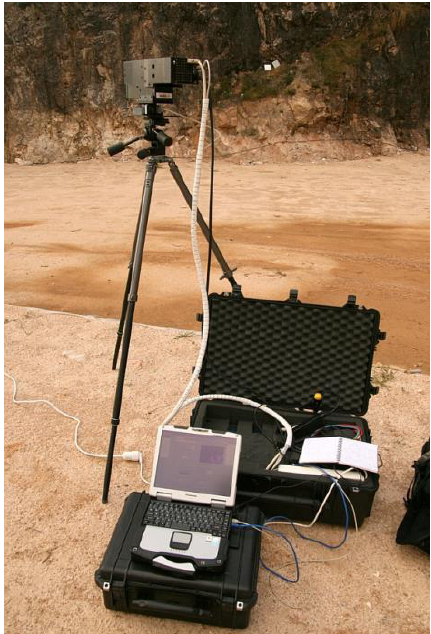
Figure 1. Tripod-based hyperspectral imaging for geological mapping of vertical cliff faces, showing HySpex SWIR-320m imager. The vertical scanning line of the sensor is moved on a rotation stage for image